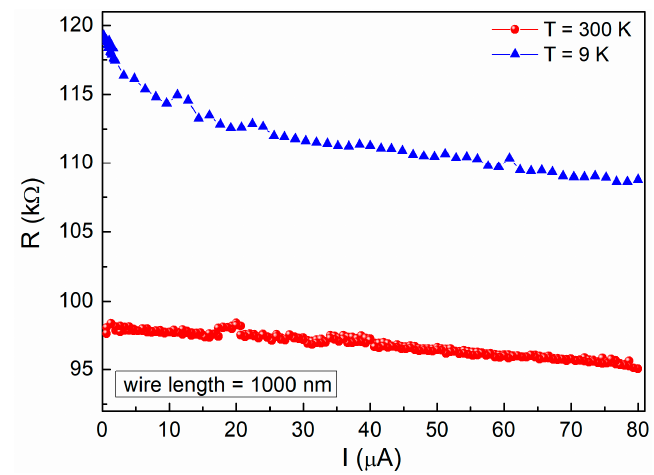
Figure 3. Static resistance versus bias current at different temperatures. The data refer to the nanowires 1000 nm-long at T = 300 K (red dots) and at T = 9 K (blue triangles). The small jumps visible in the traces are reproducible and are, most probably, due to different current paths in the sample.